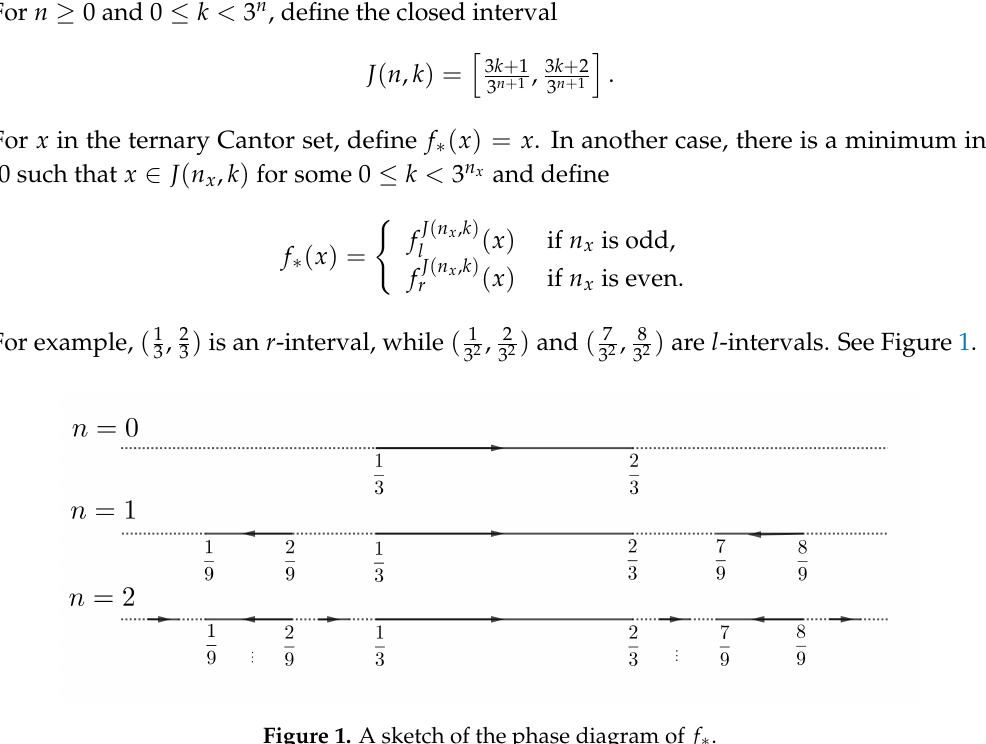
Figure 1. A sketch of the phase diagram of f ∗